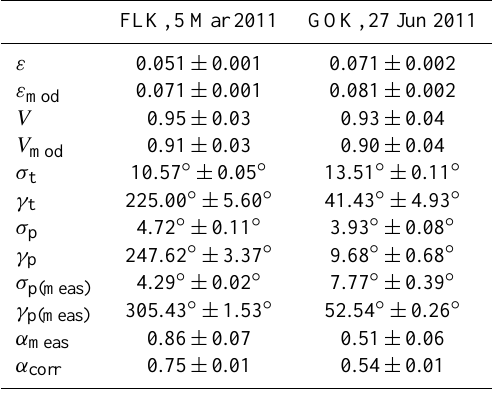
Figure 7. Workflow to correct daily albedo values.